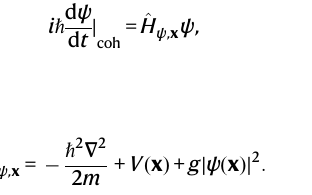
(Fig. 1k – m,seeFig. S3 for more separations).For larger separations,we